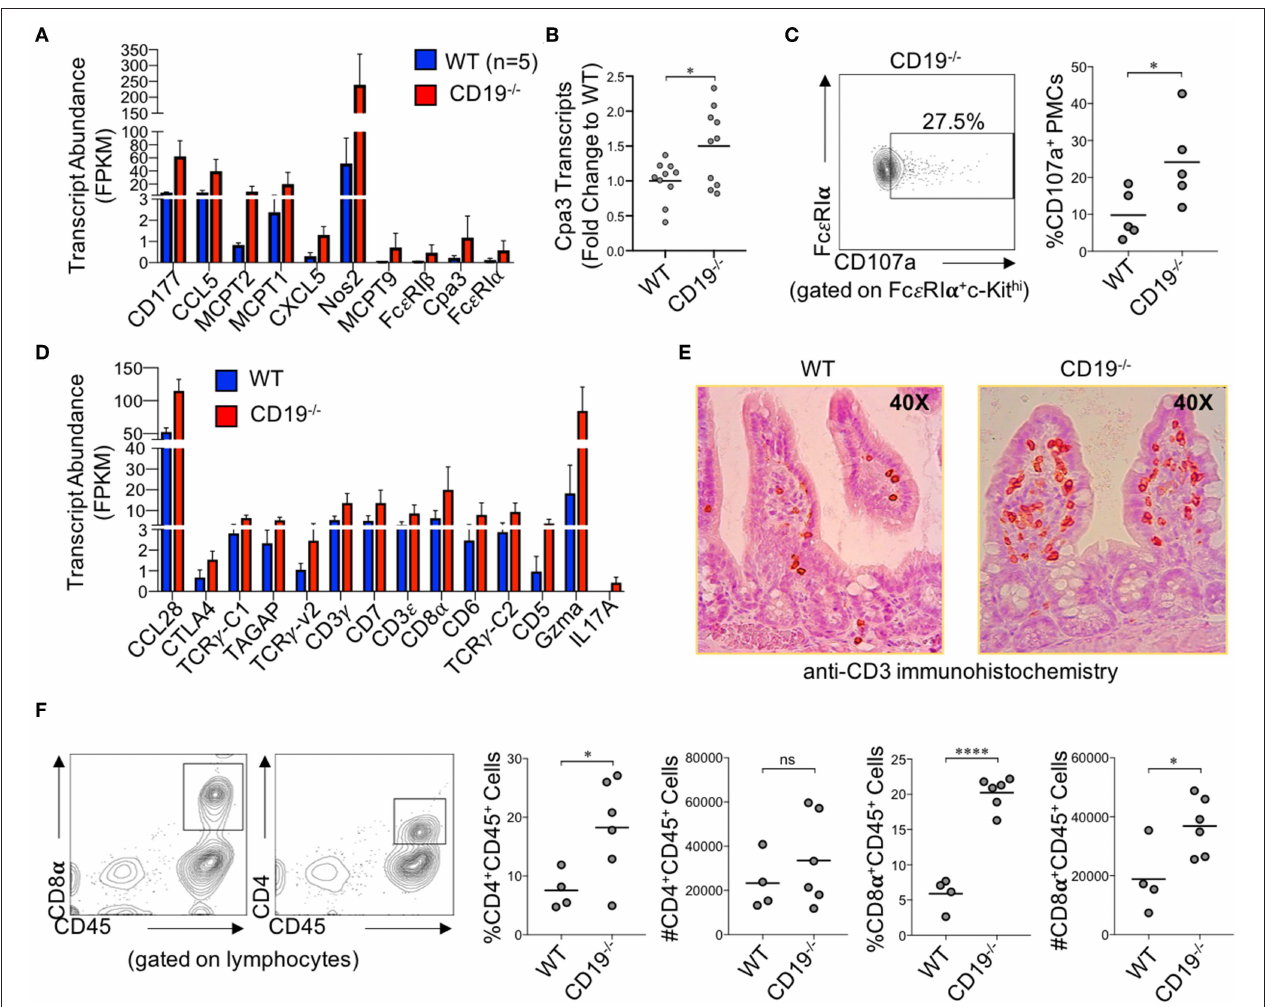
FIGURE 5 | Immune Involvement in Intestinal Malabsorption in CD19 − / − . (A) DE gene transcripts in CD19 − / − mice associated with innate immunity. (B) qRT-PCR of Cpa3 mRNA expression. (C) Representative flow cytometry plot of activated peritoneal mast cells with relative abundance shown. (D) DE gene transcripts in CD19 − / − mice associated with adaptive immunity. (E) Representative anti-CD3 immunohistochemistry staining of WT and CD19 − / − ileal sections. (F) The relative and absolute abundance of CD4 and CD8T cells isolated from the gut mucosa (lamina propria) of WT and CD19 − / − are provided. (A,D) Quasi-likelihood ratio test to identify significantly DE genes. (B,C,F) Student’s t -test; ns, non-significant, * = p < 0.05, **** = p < 0.0001.